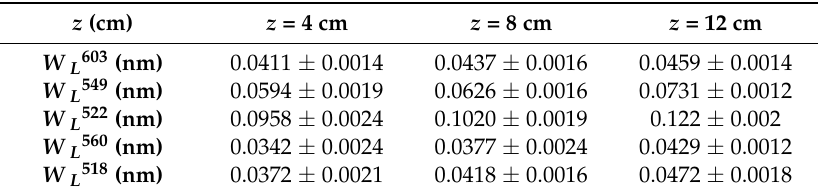
Table 2. Lorentzian FWHM of lines Ar I 603.2 nm, Ar I 549.6 nm, Ar I 522.1 nm, Ar I 560.7 nm, and Ar I 518.8 nm measured at different axial plasma